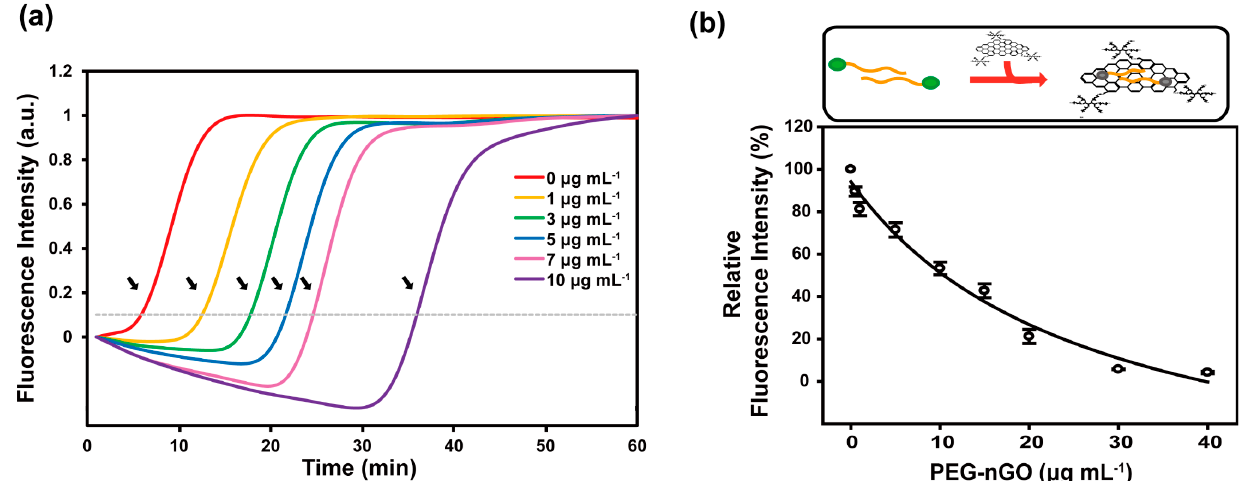
Figure 2. Adsorption of ssDNA LAMP primers on PEG-nGO. ( a ) Real − time fluorescence monitoring of LAMP − amplified products without target under different concentrations of PEG-nGO (0, 1, 3, 5, 7, and 10 µ g mL − 1 ). ( b ) Schematic illustration showing fluorescence quenching of FAM − labeled ssDNA after adsorption onto PEG-nGO (illustration in box). Fluorescence quenching of FAM − labeled ssDNA with increasing concentration of PEG-nGO. FAM − labeled DNA was incubated with varying PEG-nGO concentration (0, 0.5, 1, 5, 10, 15, 20, 30, and 40 μ g mL − 1 ) and the fluorescence intensity was measured at an excitation wavelength of 485 nm and an emission wavelength of 535 nm.